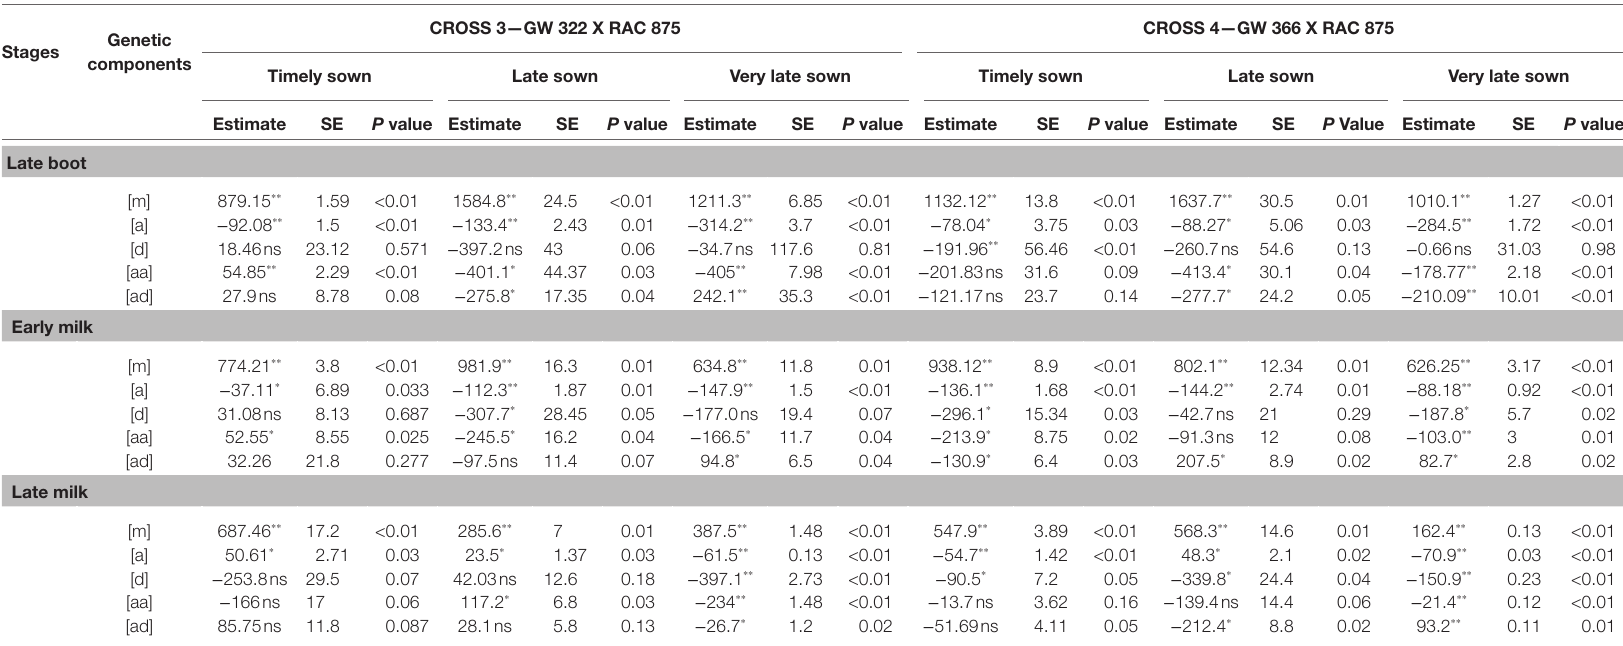
TABLE 7 | Estimates of genetic components, mid-parent [m], additive effect [a], dominance effect [d], additive X additive [aa], dominance X dominance [dd], additive X dominance [ad], standard errors (SE), and Student’s t significance level ( P ) for the models with the best Chi-square fit for stomatal conductance measured parents, F 1 , F 2 , BC 1 P 1 , and BC 2 P 2 for crosses GW 322 X RAC 875 and GW 366 X RAC 875 during three growth stages under timely, late, and very late sown